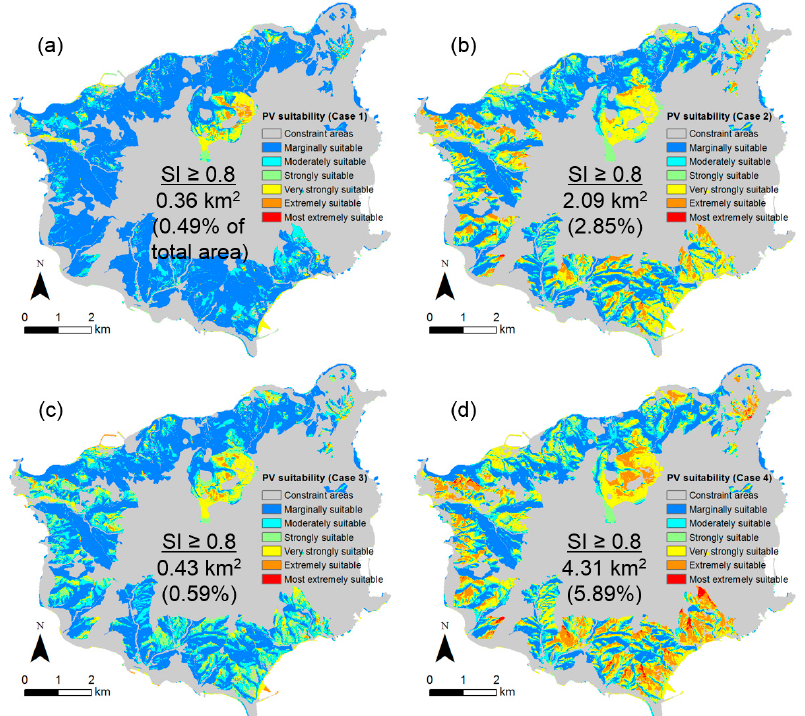
Figure 6. Sensitivity analysis of the SI results for PV solar farm development: ( a ) Case 1: Even weight for all factor variables; ( b ) Case 2: Only solar PV energy production factors (solar irradiation, sunshine hours, average daily temperature in summer); ( c ) Case 3: Only natural environmental factors (excluding proximity to grid connection and proximity to road) and ( d ) Case 4: All factors except slope factor.